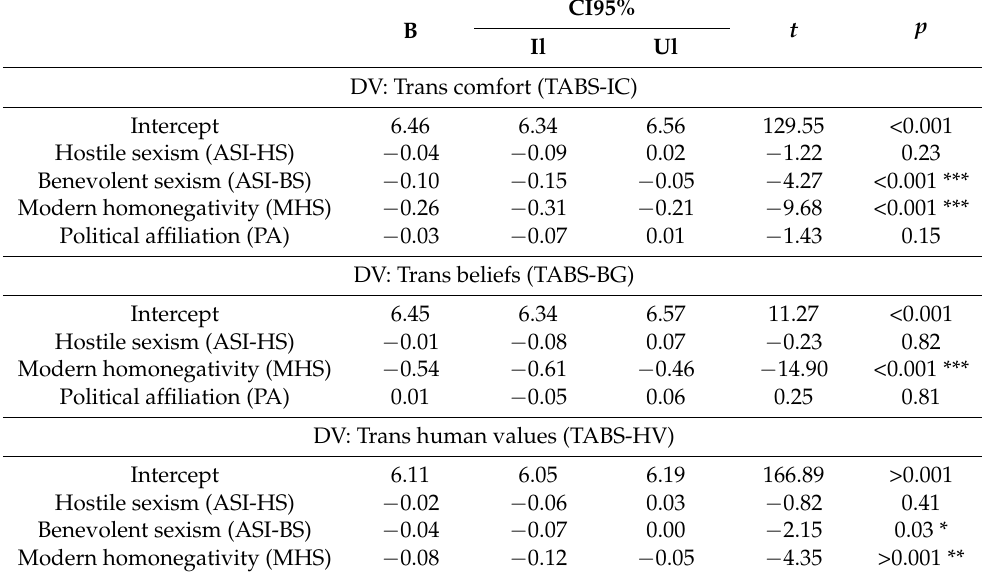
Table 4. Multiple linear regression models for each dimension of the